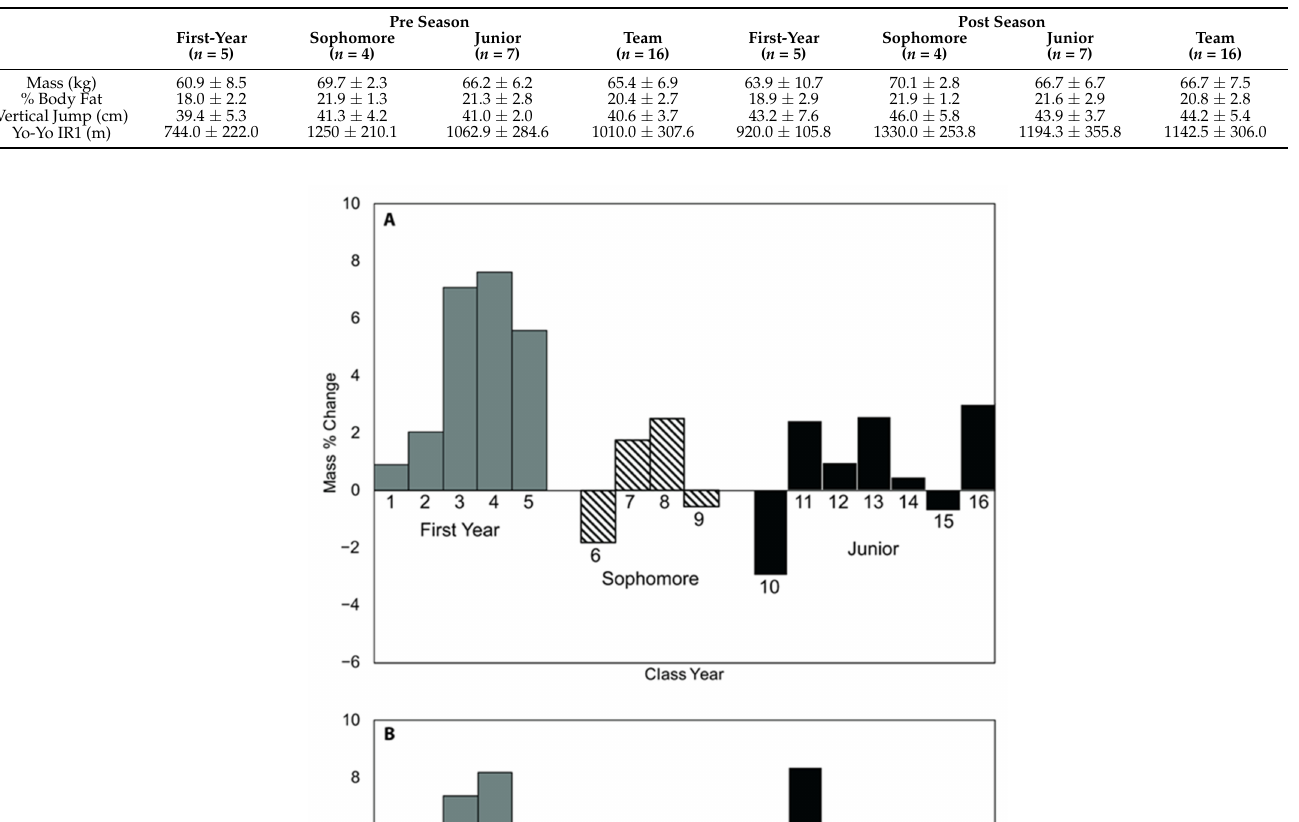
Table 1. Pre and post season data of anthropometric and fitness measures for first-year ( n = 5), sophomore ( n = 4), and junior ( n = 7) athletes, in addition to team ( n = 16) data. Mean ± standard deviation reported.